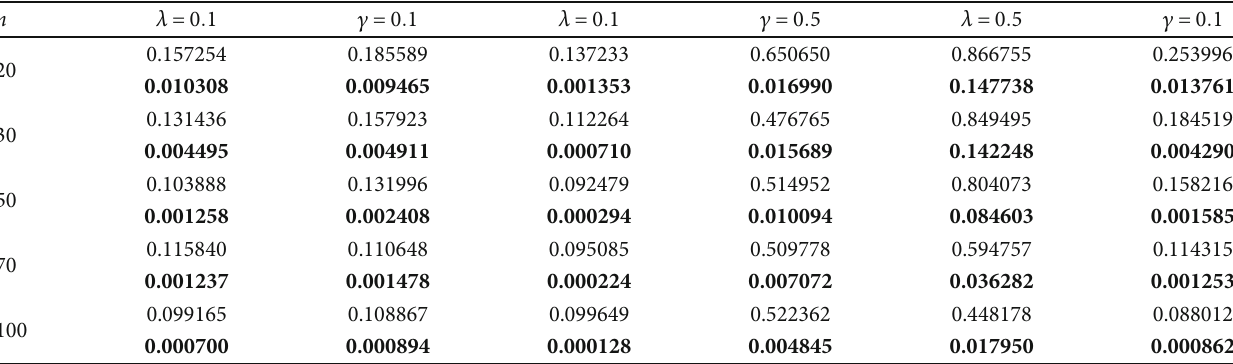
Table 1: BEs and PRs under SELF and noninformative prior using λ = 0 : 1, 0 : 5 and γ = 0 : 1, 0 : 5 .